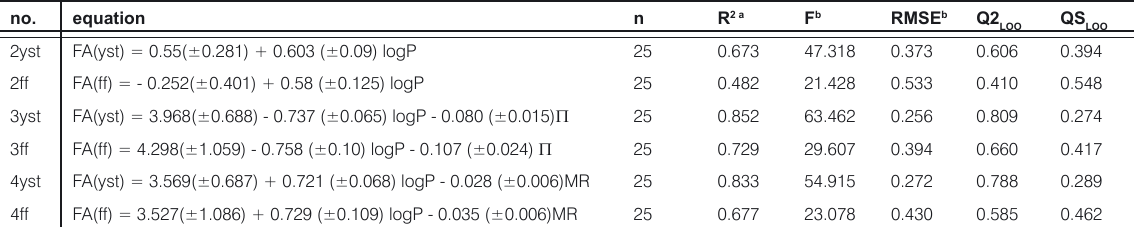
a correlation parameters: r – correlation coefficient, r 2 – squared correlation coefficient. b statistical parameters: F – variance ratio, RMSE – the Root-Mean-Squared Errors.